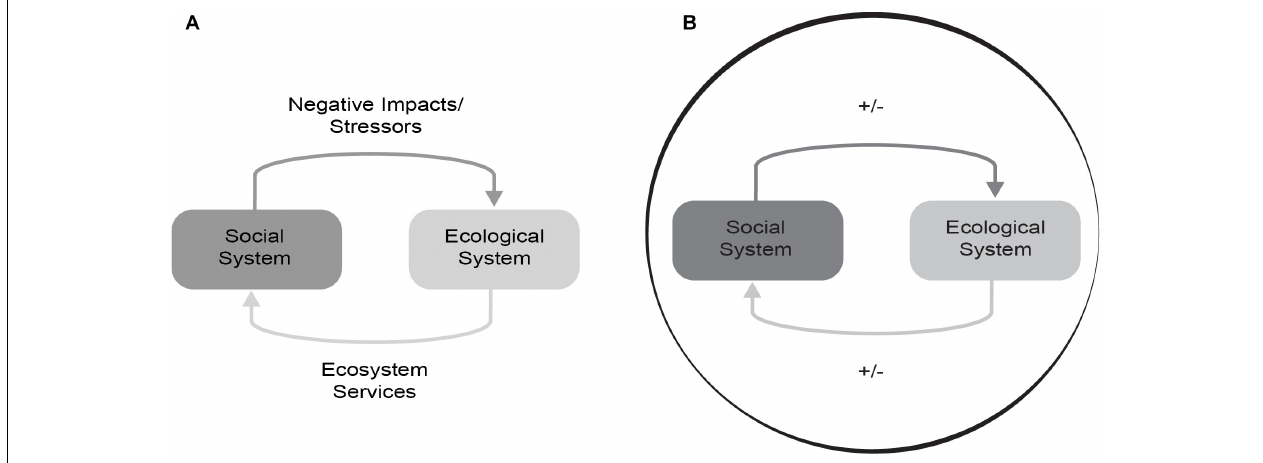
FIGURE 3 | (A) One-dimensional depiction of reciprocity within a social-ecological system, with the social system exerting pressure on the ecological system (biophysical components) and receiving benefits through ecosystem services (based on Kittinger et al., 2012). (B) Emergent stakeholder perception of reciprocity, where the social system and ecological system experience both positive and negative interactions with each other, and people generally experience the system as a